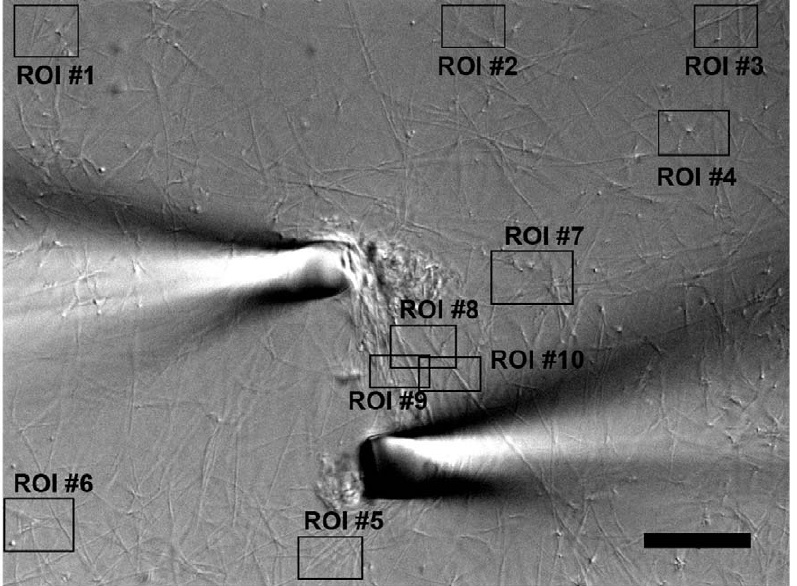
Figure 5. Experimental setup and ROI selection. Each experiment began with collagen polymerized in a bioreactor, both between functionalized pipettes and in the periphery. For edge intensity integration, ROIs were selected, using the same general pattern each time, but choosing ideal locations in each section to monitor large perpendicular or parallel fibrils. Note the large perpendicular fibrils in ROI # 4. These fibrils make an excellent visual control, for while they provide little weighted edge intensity, they are easy to track visually and are ideal control fibrils – they should experience little or no strain. Bar =20 m m.